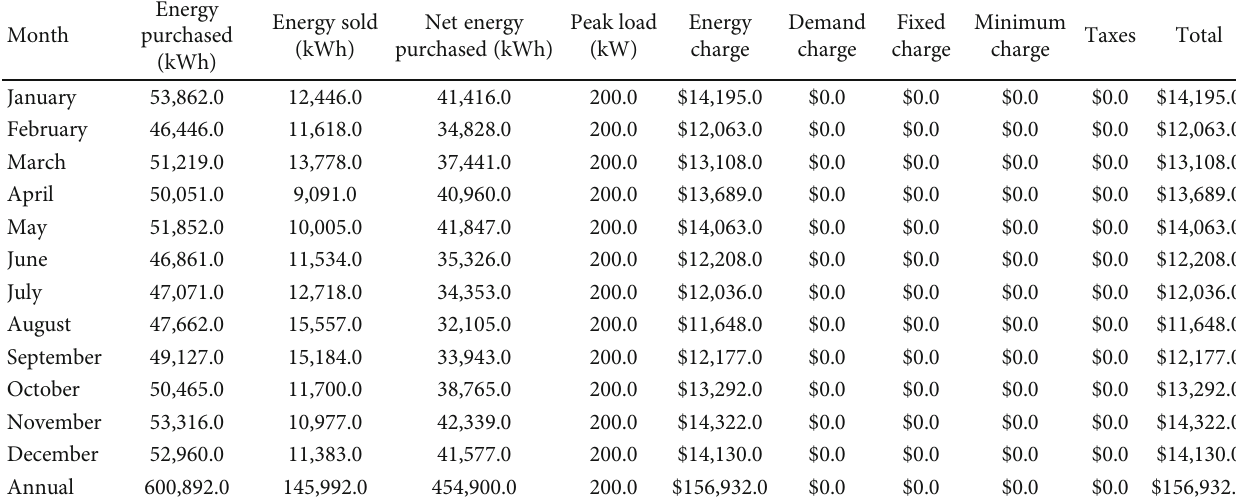
Table 17: Utility monthly summary — proposed system (Burundi).